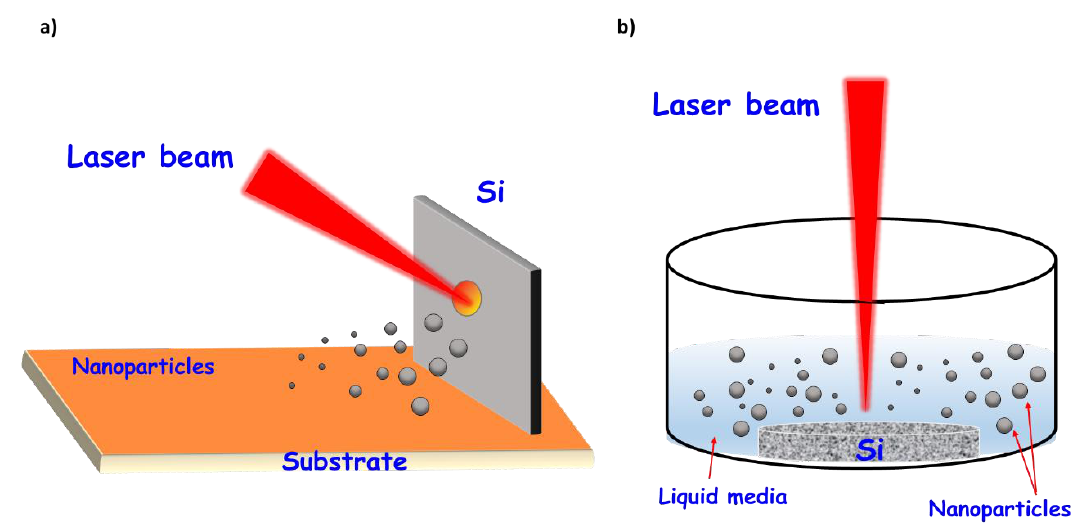
Figure 2. Ablation process performed in ( a ) “dry” and ( b ) “wet” conditions.